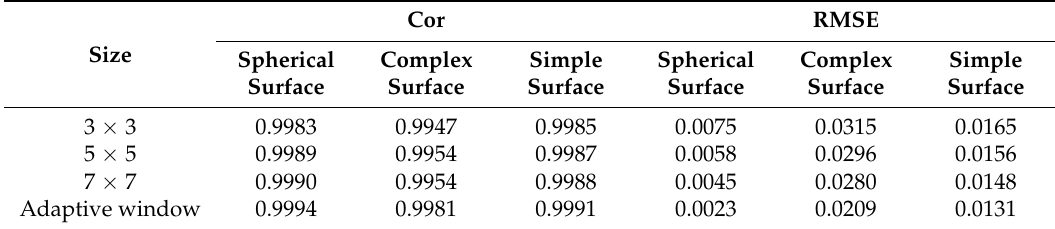
Table 3. Evaluation result of the recovery effect of the three models reconstructed using different evaluation windows of F TEN.